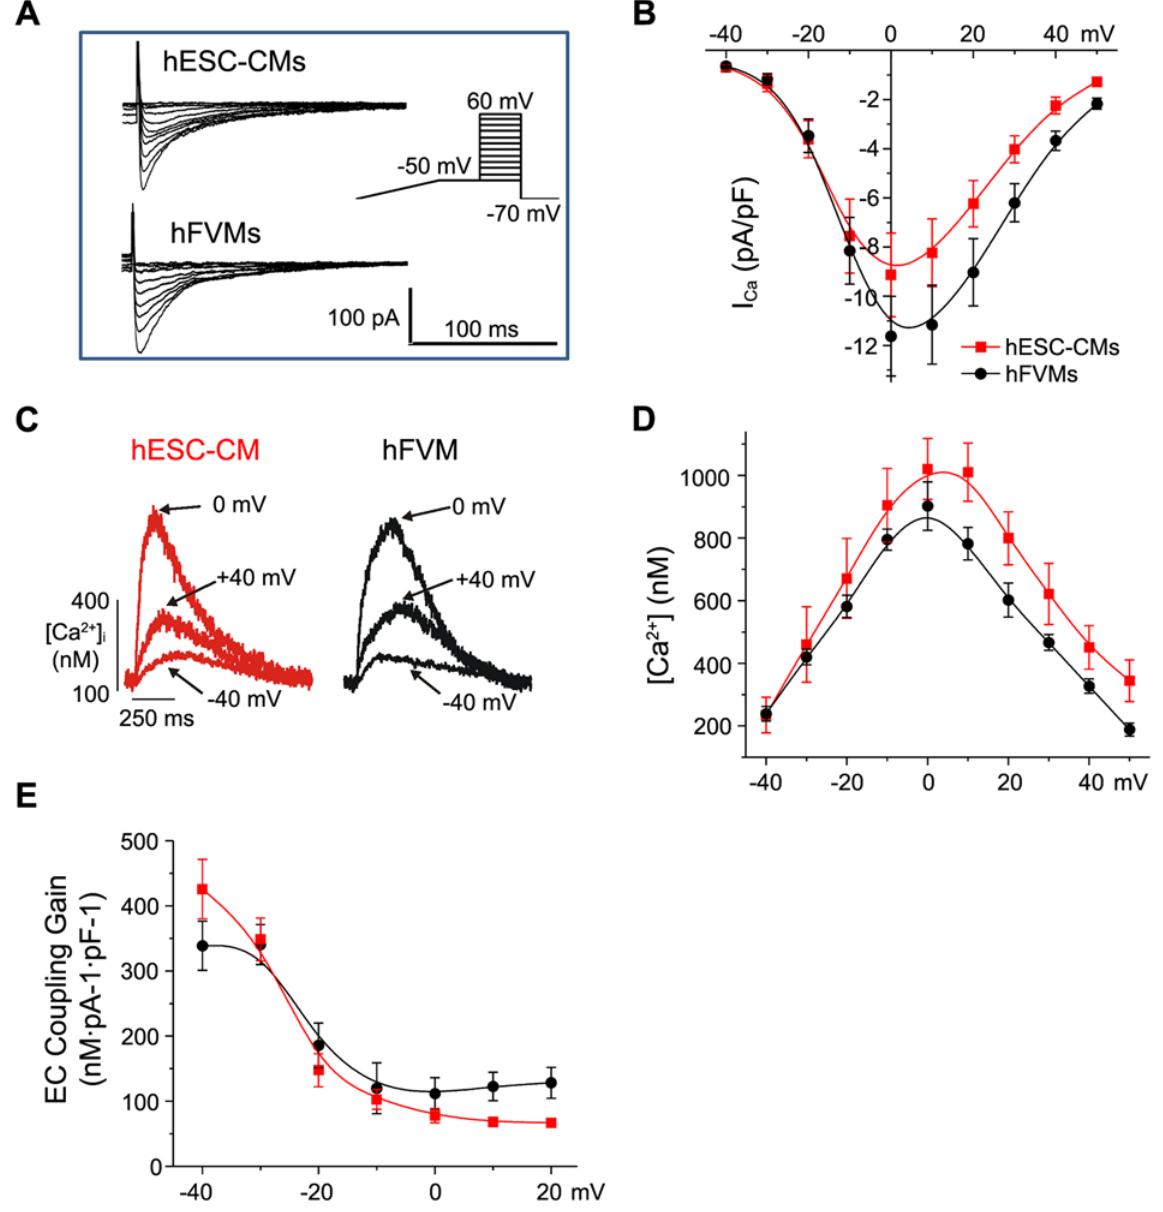
Figure 3. Voltage dependencies of I Ca and [Ca 2 + ] i during EC coupling in hESC-CMs and hFVMs. A. I Ca traces from typical hESC-CMs and hFVMs. I Ca was evoked elicited using the voltage protocol depicted in the inset to the right. In brief, cells were slowly depolarized from the holding potential of 2 70 mV to 2 50 mV, where they were held to inactivate the Na + current. Cells were then depolarized from 2 50 mV to test potentials ranging from 2 40 to + 60 mV for 200 ms. B. Current-voltage relationships of I Ca in hESC-CMs (red) and hFVMs (black). C. [Ca 2 + ] i transients evoked by I Ca following depolarization to 2 40, 0, + 40 mV in representative hESC-CMs and hFVMs. D. Voltage-dependence of the amplitude of the [Ca 2 + ] i transient in hESC-CMs and hFVMs. E. Voltage-dependence of the EC coupling gain factor in hESC-CMs and hFVMs.